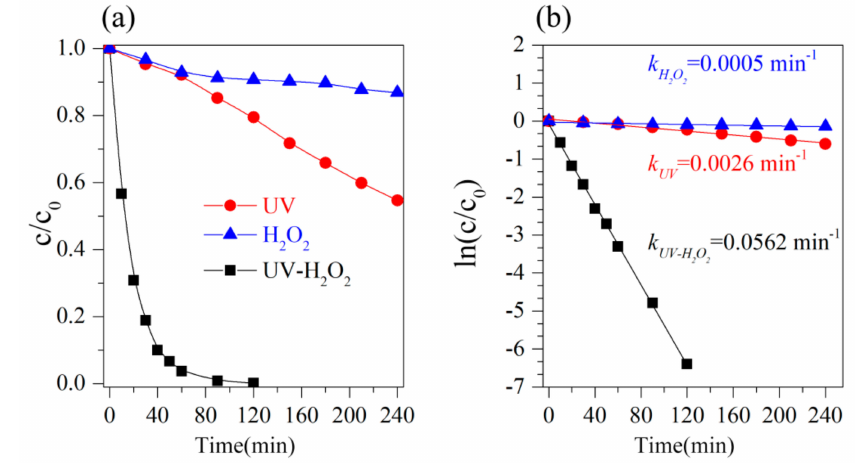
Figure 7. E ff ect of di ff erent methods ( a ) on degradation; e ff ect of di ff erent methods ( b ) on the rate constant of degradation kinetics; [C 4 BthPF 6 ] = 0.1 mM, t = 45 °C, pH = 5.06, [H 2 O 2 ] = 100